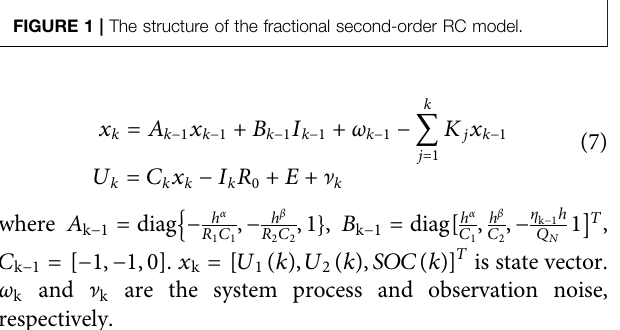
] k and k are the system process and observation noise, respectively.